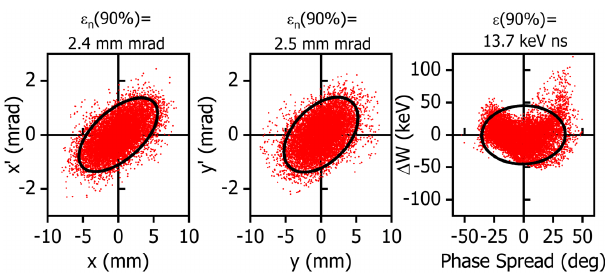
FIG. 23. Transverse and longitudinal particle distributions at 68 MeV behind a 15 m drift and a six-gap debuncher.